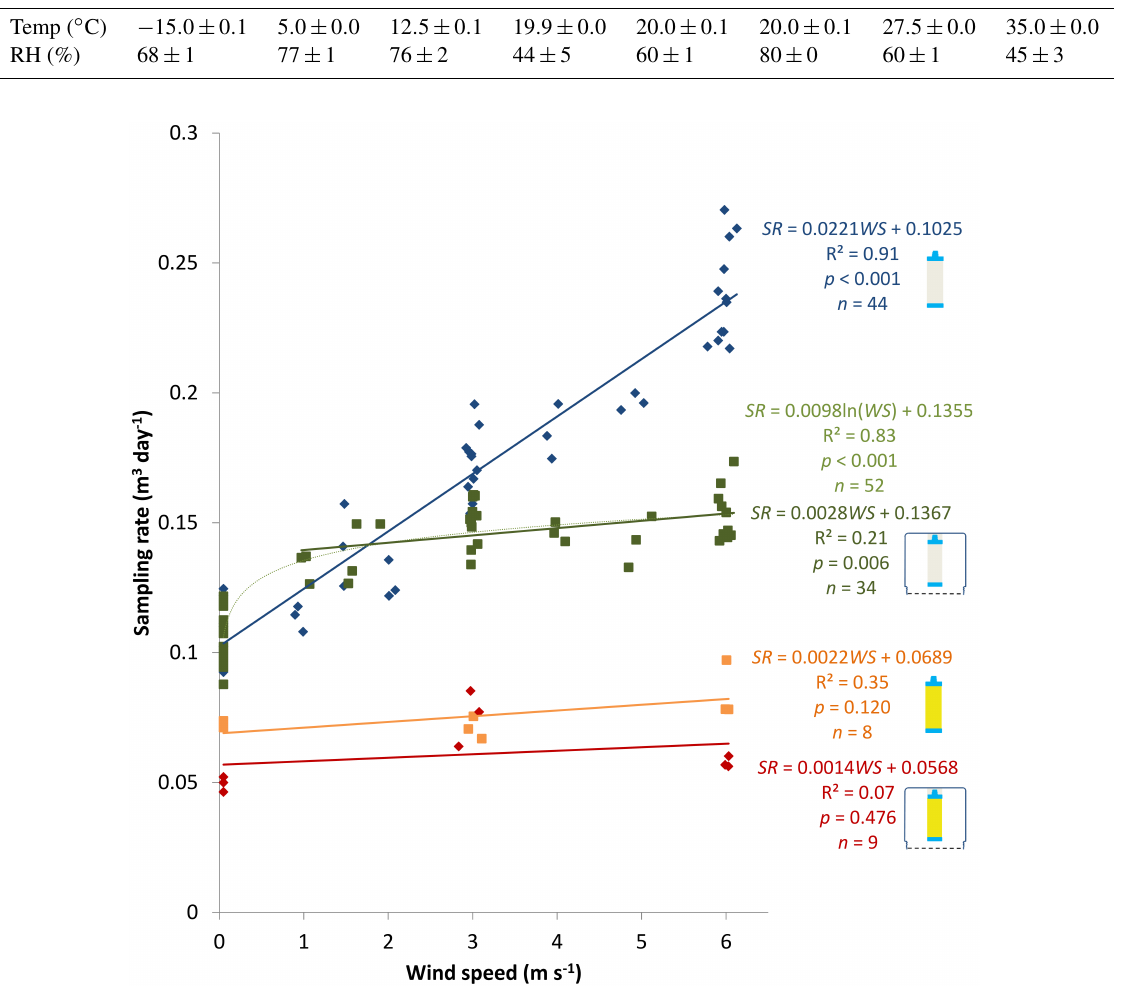
Figure 1. The effect of wind speed on the sampling rate of four different configurations of a passive air sampler for gaseous mercury. Configuration 1: white Radiello ® , with protective shield ( (cid:4) , green); configuration 2: white Radiello ® , without protective shield ( (cid:7) , blue); configuration 3: yellow Radiello ® , with protective shield ( (cid:4) , orange); configuration 4: white Radiello ® , without protective shield ( (cid:7) , red). Standard error of slope and y intercept are give in Table S1 in the